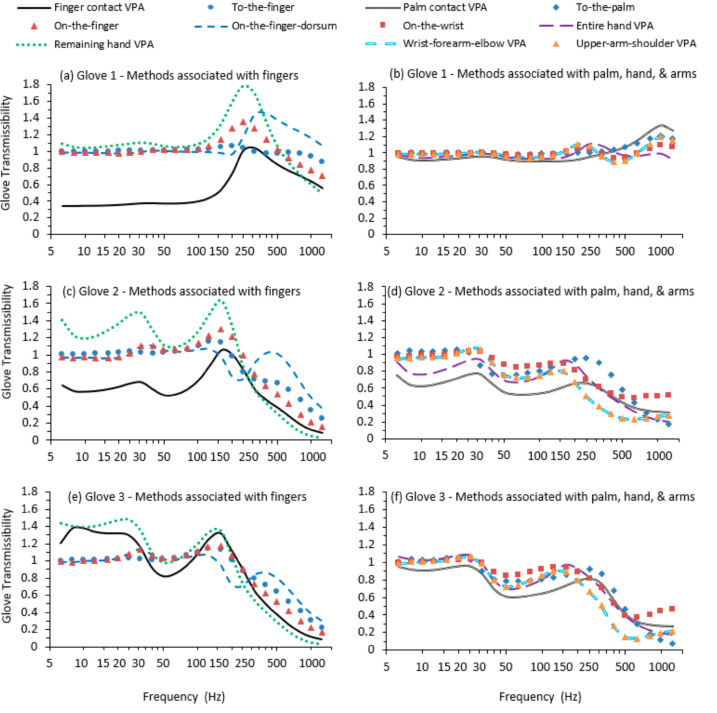
Figure 4. Comparisons of the glove vibration transmissibility spectra determined using three types of methods: the vibration power absorption (VPA) method—the VPA-based glove vibration trans- missibility calculated using Equation (24), which includes Finger contact VPA, Palm contact VPA, Remaining hand VPA, Entire hand VPA, Wrist–forearm–elbow VPA, Upper-arm–shoulder VPA; the to-the-hand method—the glove vibration transmissibility at the fingers or palm of the hand calcu- lated using Equation (4) or Equation (5), which includes To-the-fingers and To-the-palm spectra; and the on-the-hand method—the glove vibration transmissibility calculated using Equation (6), which includes On-the-fingers, On-the-finger-dorsum, and On-the-wrist spectra. ( a ) Methods associated with fingers for Glove 1; ( b ) Methods associated with palm, hand, and arms for Glove 1; ( c ) Methods associated with fingers for Glove 2; ( d ) Methods associated with palm, hand, and arms for Glove 2; ( e ) Methods associated with fingers for Glove 3; ( f ) Methods associated with palm, hand, and arms for Glove